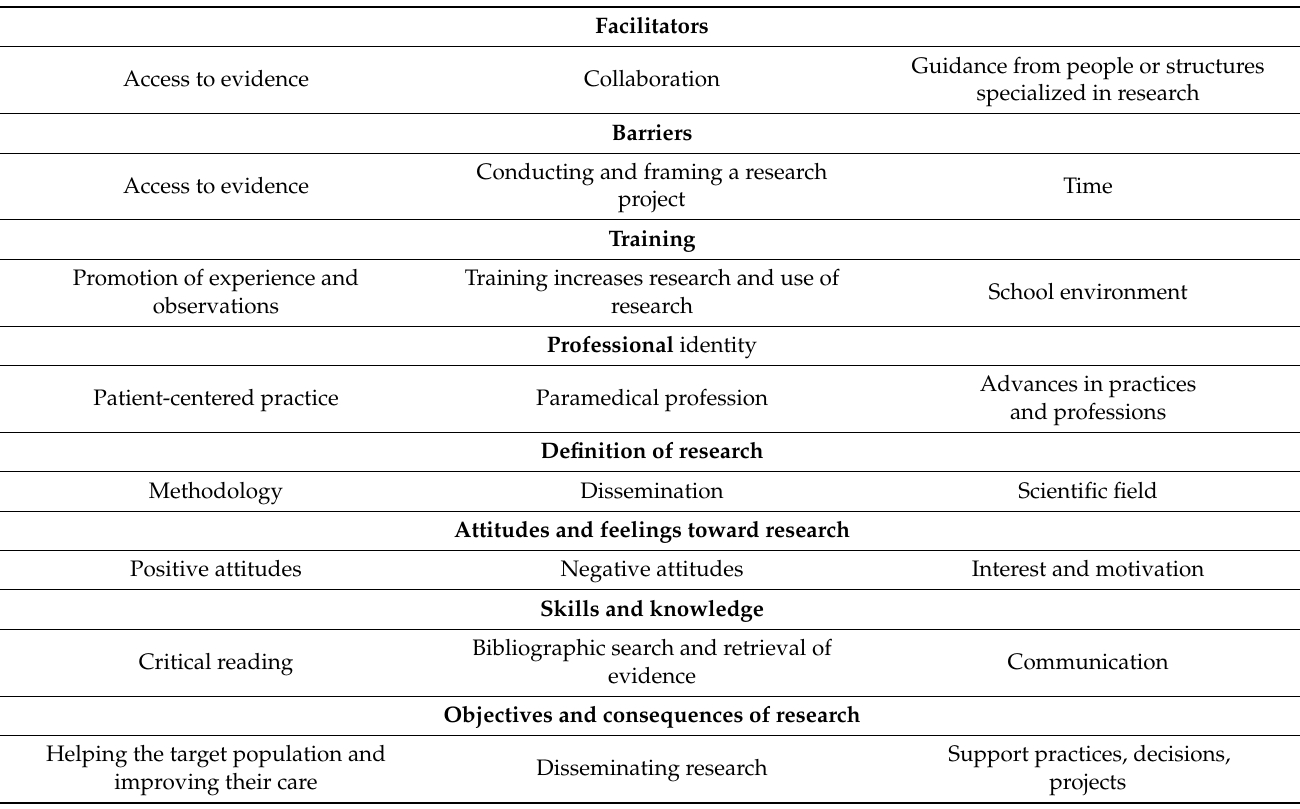
Table 4. Themes and most frequent sub-themes extracted from the 11 interviews.